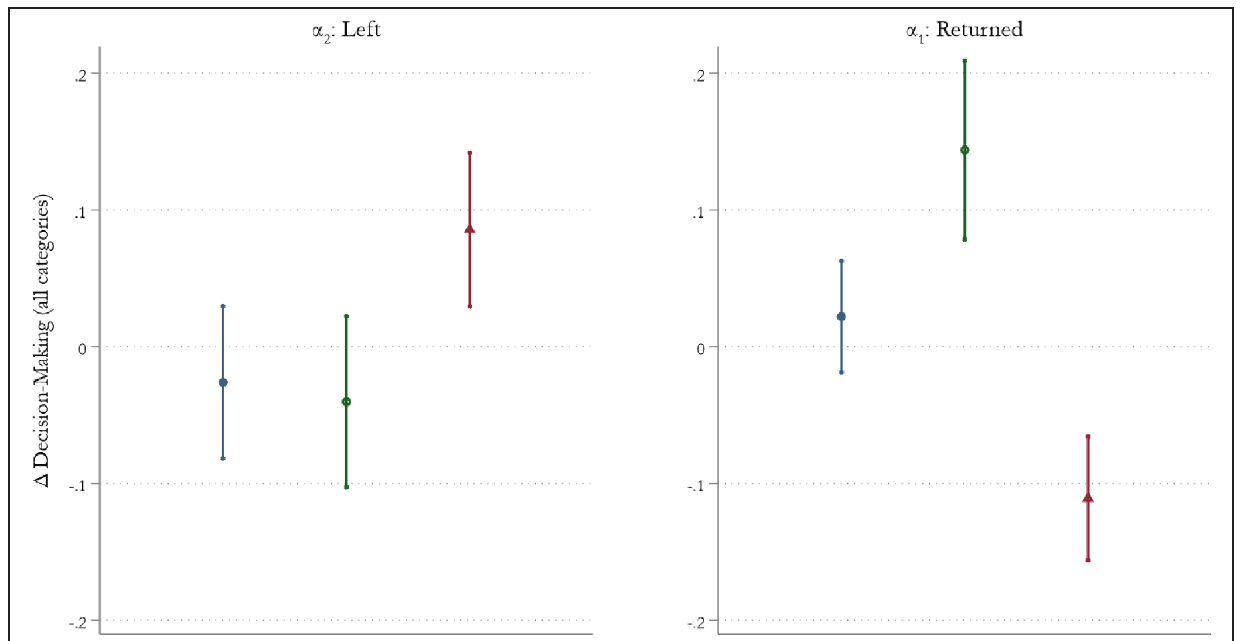
Figure 2 Persistence in women’s decision-making